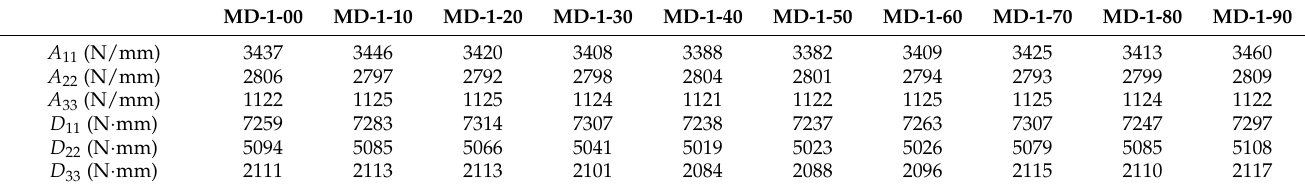
Table 5. The selected stiffnesses with 1% imperfections of compression in the MD shape and with different offsets.